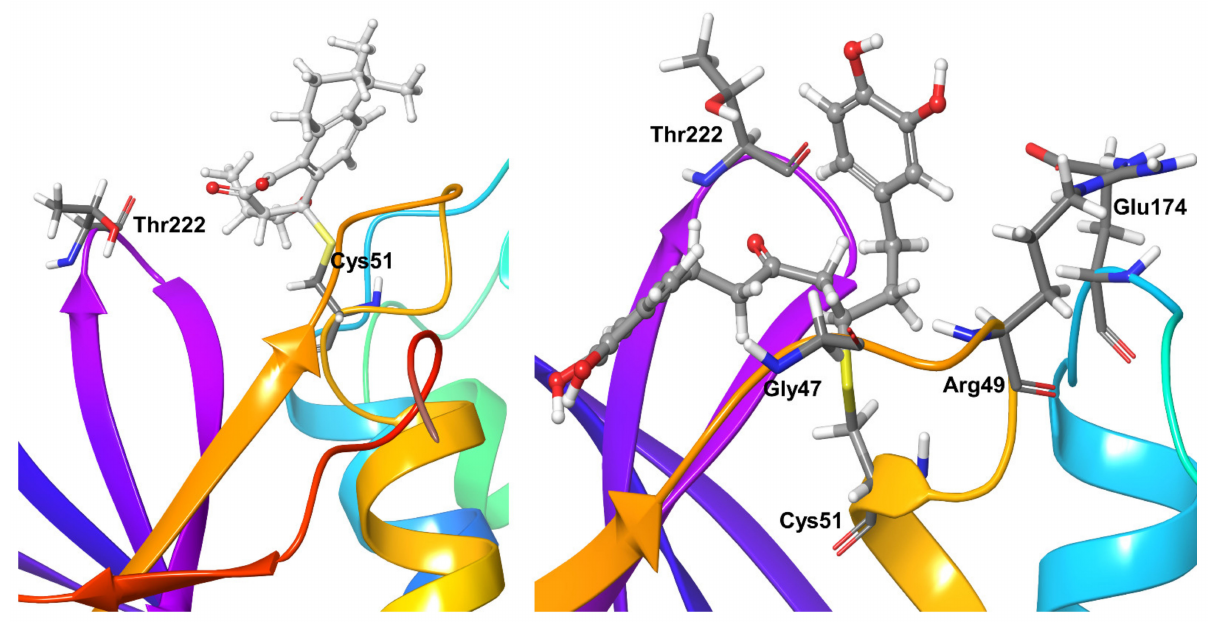
Figure 11. Stable interactions observed during MD refinement simulations of top poses of Compound 3 ( left ) and 4 ( right ) with OTUB-2. The ligands are shown in ball and stick representation, stable and moderately stable protein-ligand interacting residues are represented as thick tubes, short-living interactions (present for less than 30% of simulation time) are represented as thin